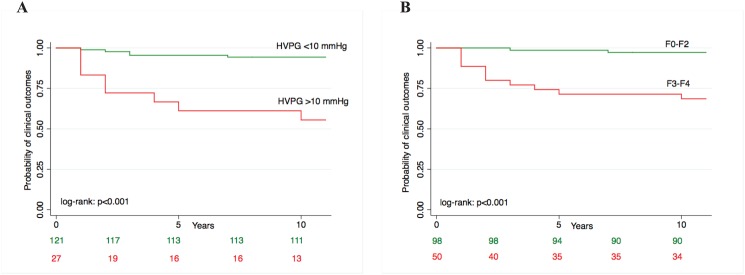
Survival curves of probability of clinical outcomes by: (A) HVPG category; (B) histologic fibrosis category.